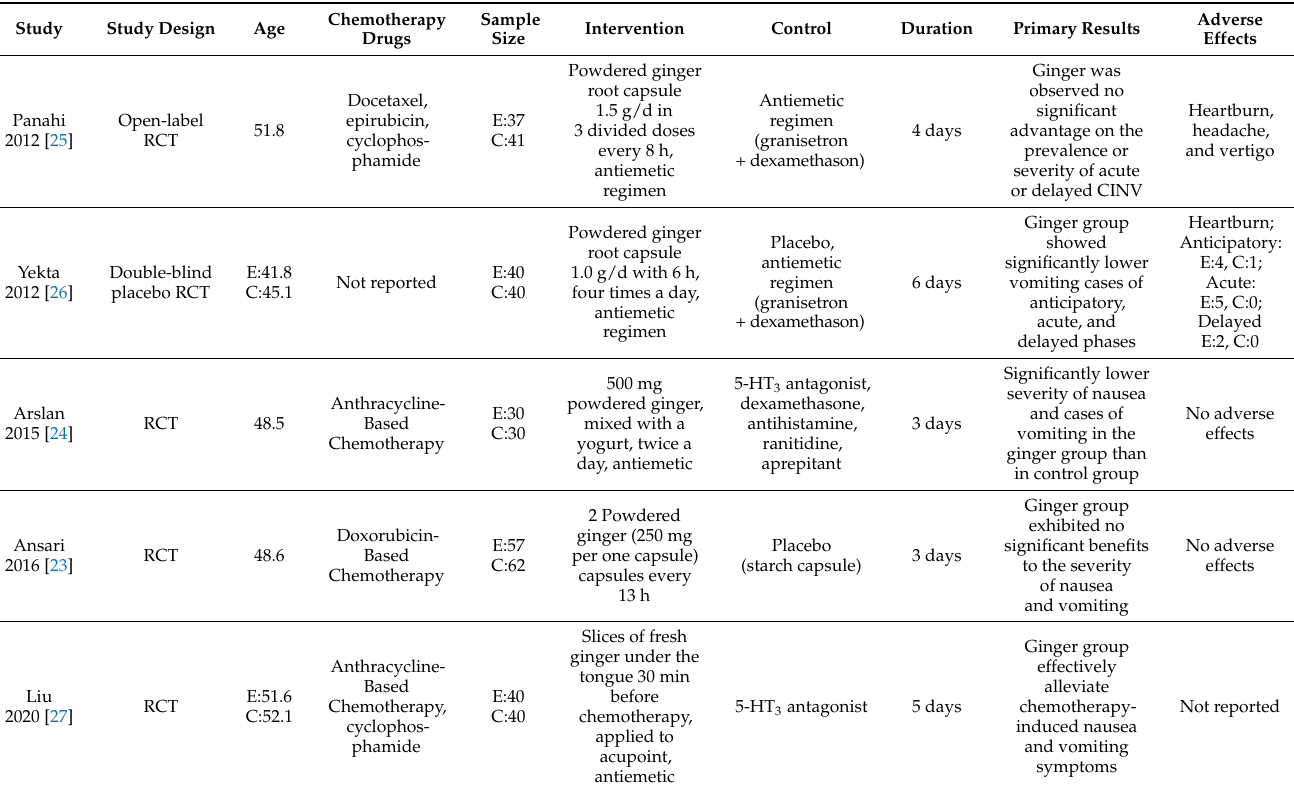
Table 1. Characteristics of included